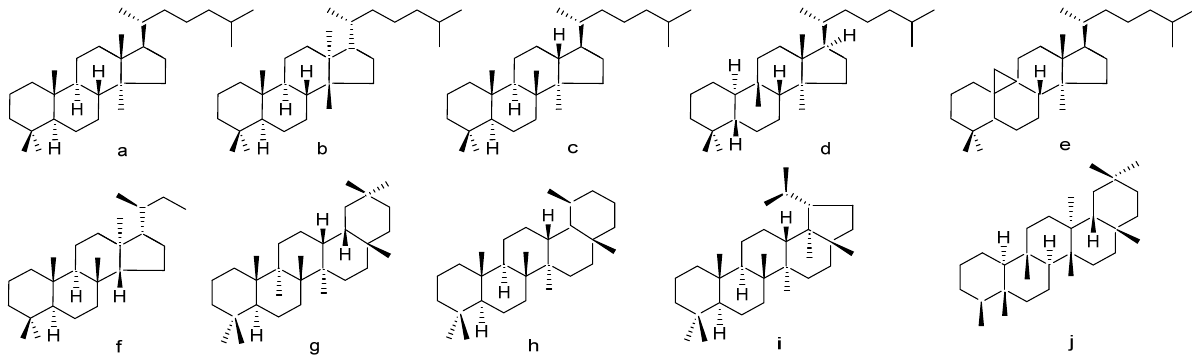
Figure 2. Chemical structures of ten kinds of triterpenoid saponins, ( a ) lanostane, ( b ) euphane ( c ) dadamane type, ( d ) cucurbitacin alkanes, ( e ) cycloxylane-type, ( f ) meliacanes ( g ) oleanane type, ( h ) ursane, ( i ) lupine, ( j ) friedelanes.